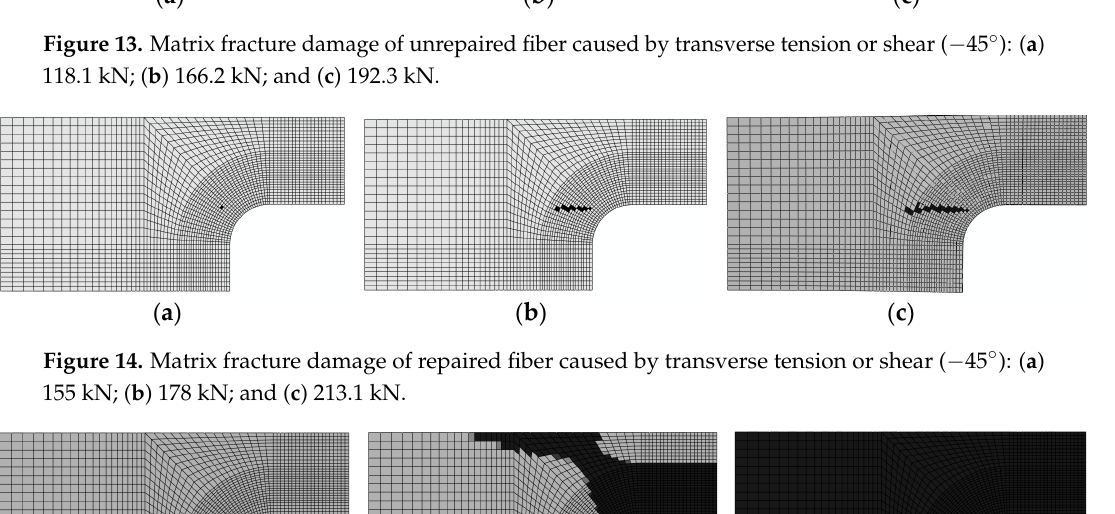
Figure 14. Matrix fracture damage of repaired fiber caused by transverse tension or shear ( − 45°): ( a ) 155 kN; ( b ) 178 kN; and ( c ) 213.1 kN. Figure 15. Matrix fragmentation damage of unrepaired fiber caused by transverse or shear compression (90°): ( a ) 41.2 kN; ( b ) 79.7 kN; and ( c ) 192.3 kN.